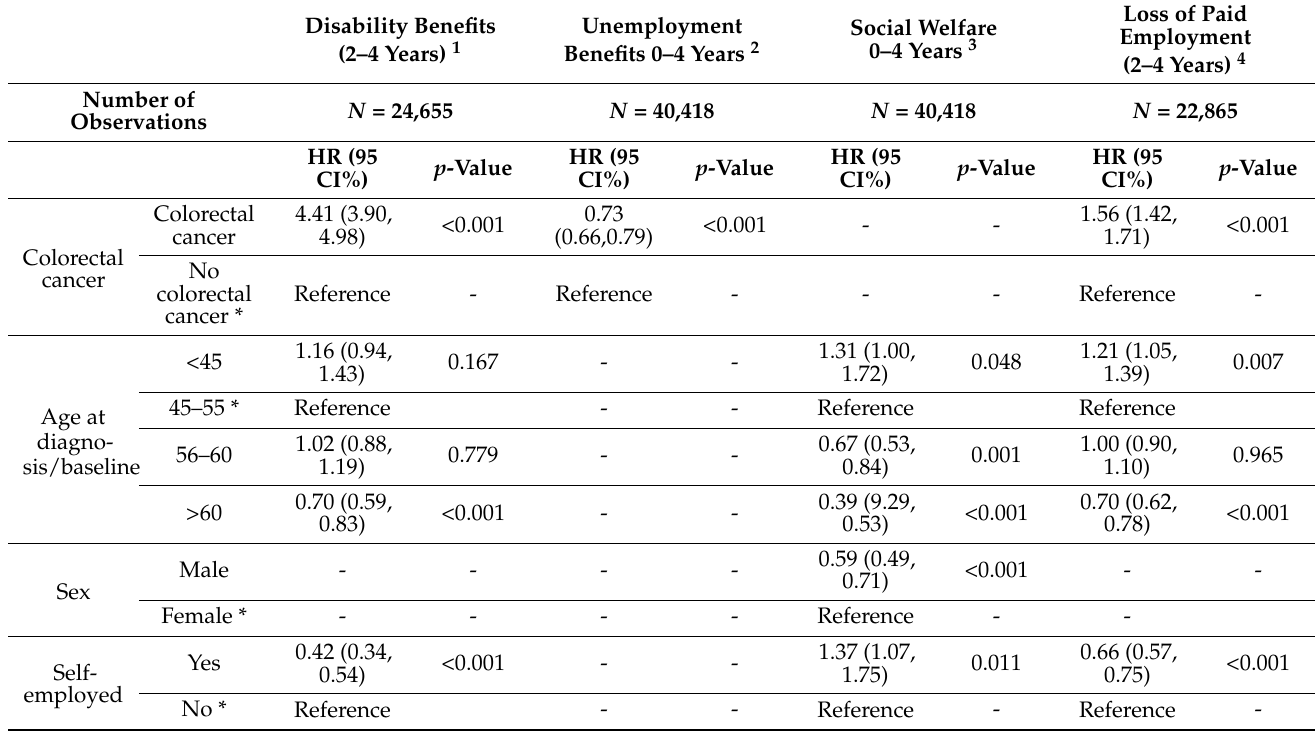
(Table 3) in a multivariate model. Table 3. Hazard ratios of work-related outcomes in multivariate models in the total cohort having paid